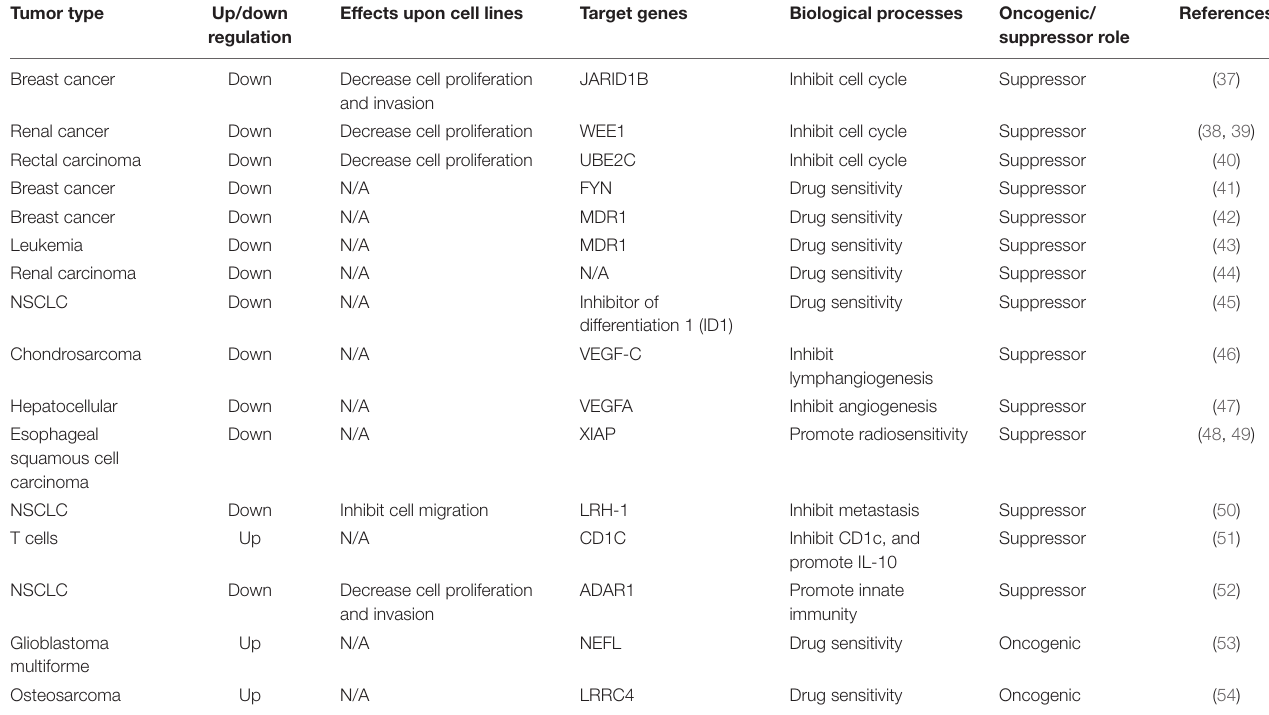
TABLE 3 | MiR-381 participated in multiple cellular